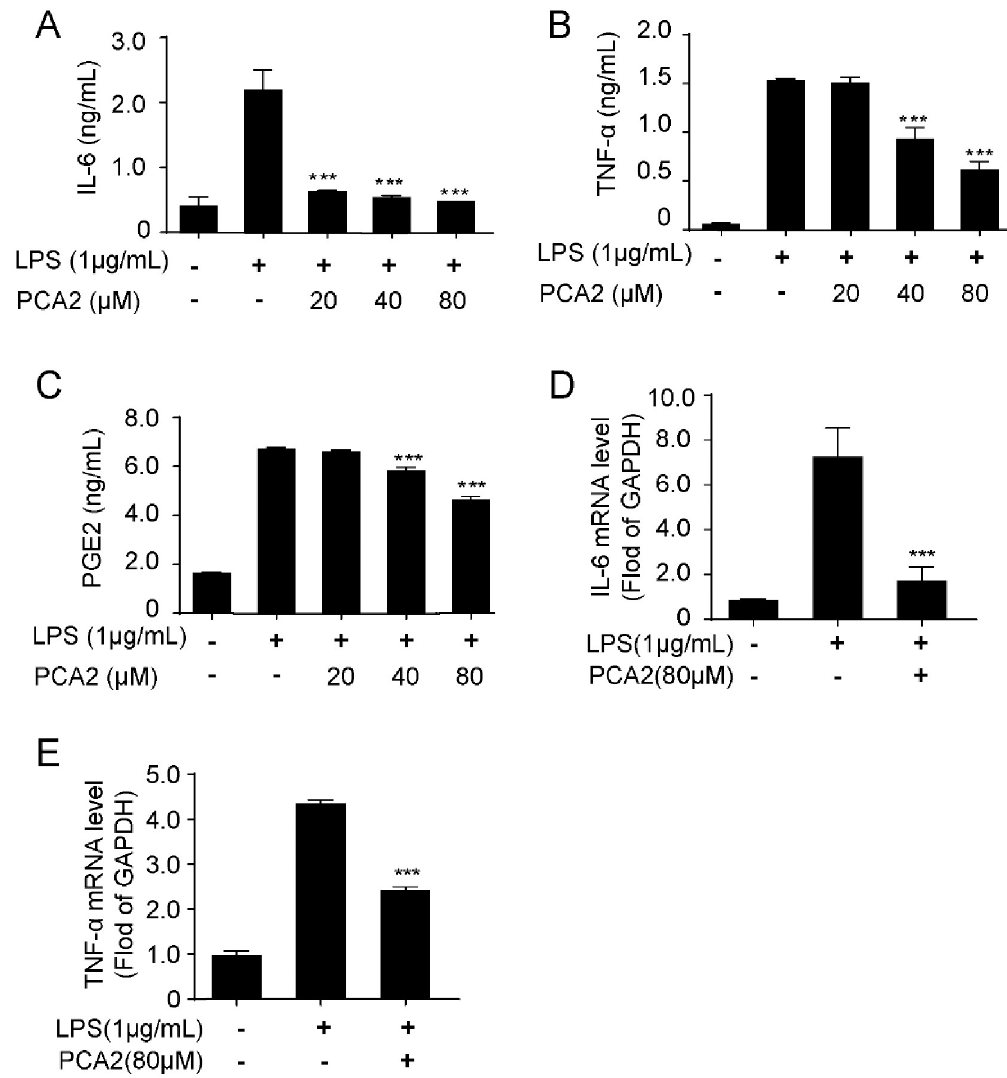
Fig 2. PCA2 inhibited pro-inflammatory cytokines release and gene expression. Cells were cultured with LPS for 18 h after treated with PCA2 (20, 40, 80 μ M) for 1 h, except for the control group. ( A ) IL-6, ( B ) TNF- α , and ( C ) PGE2 were investigated by ELISA kits (n = 5). Cells were cultured with LPS for 2 h after treated with PCA2 (80 μ M) for 1 h, except for the control group. The mRNA expression of ( D ) IL-6 and ( E ) TNF- α were tested by qRT-PCR (n = 3). � p < 0.05, p < 0.01, ��� p < 0.001 vs. LPS